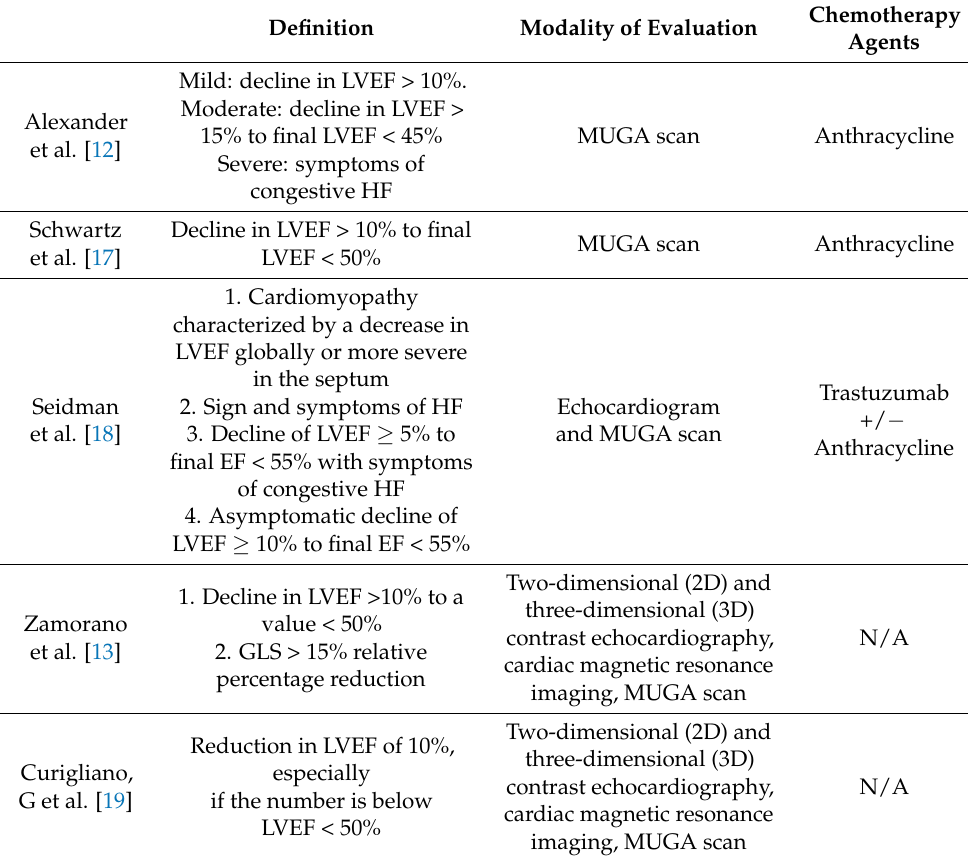
Table 1. Definitions of cardiotoxicity, modality of evaluation and chemotherapy agents.